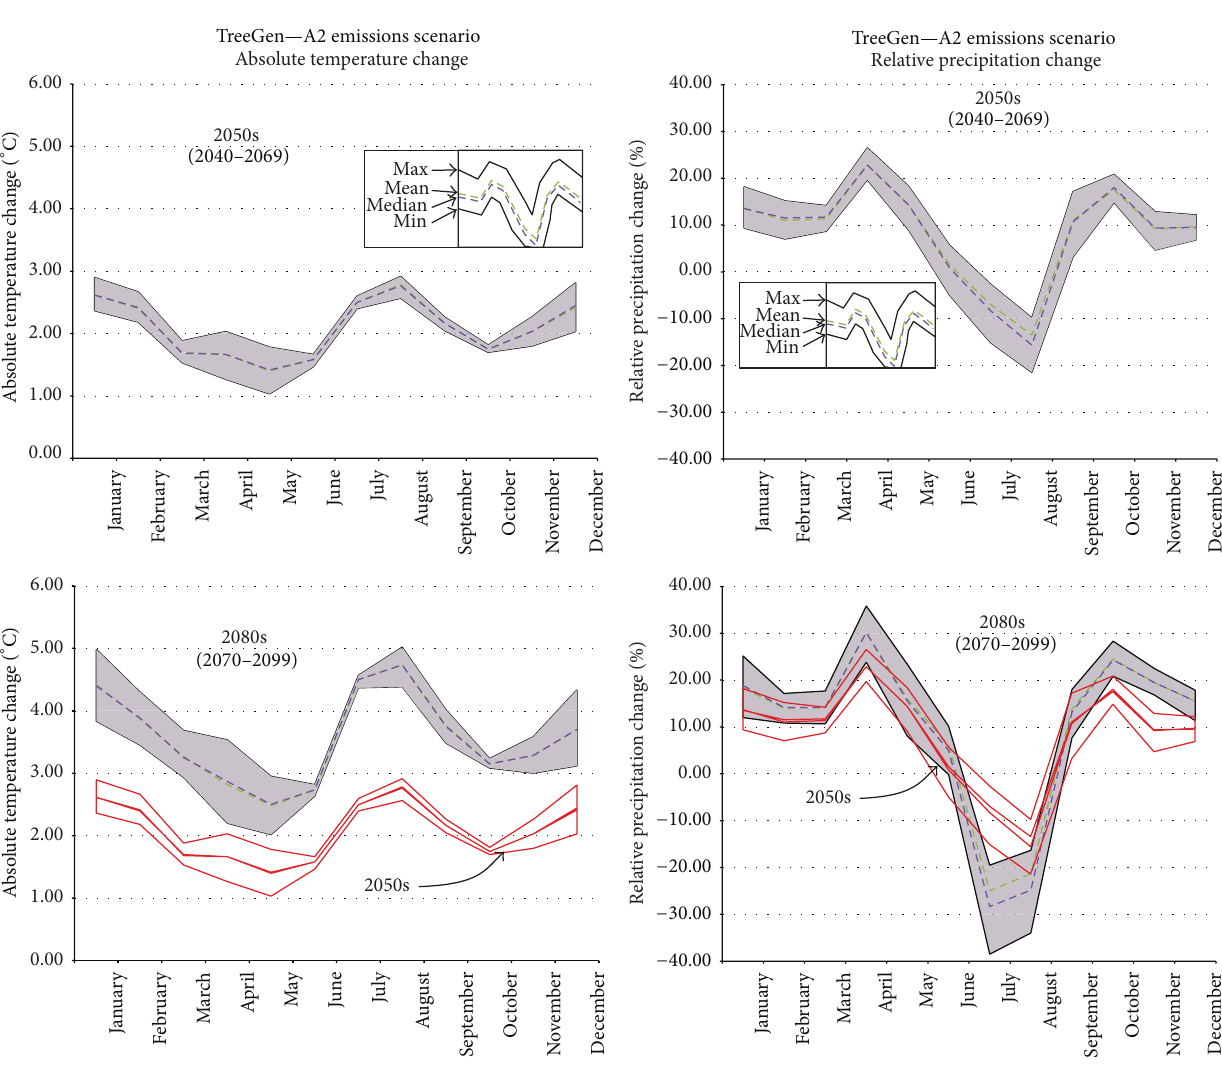
Figure 9: Projected climate shifts for the 2050s and 2080s for the Cowichan Region (TreeGen ensemble—A2 emissions scenario). Data from Pacific Climate Impacts Consortium